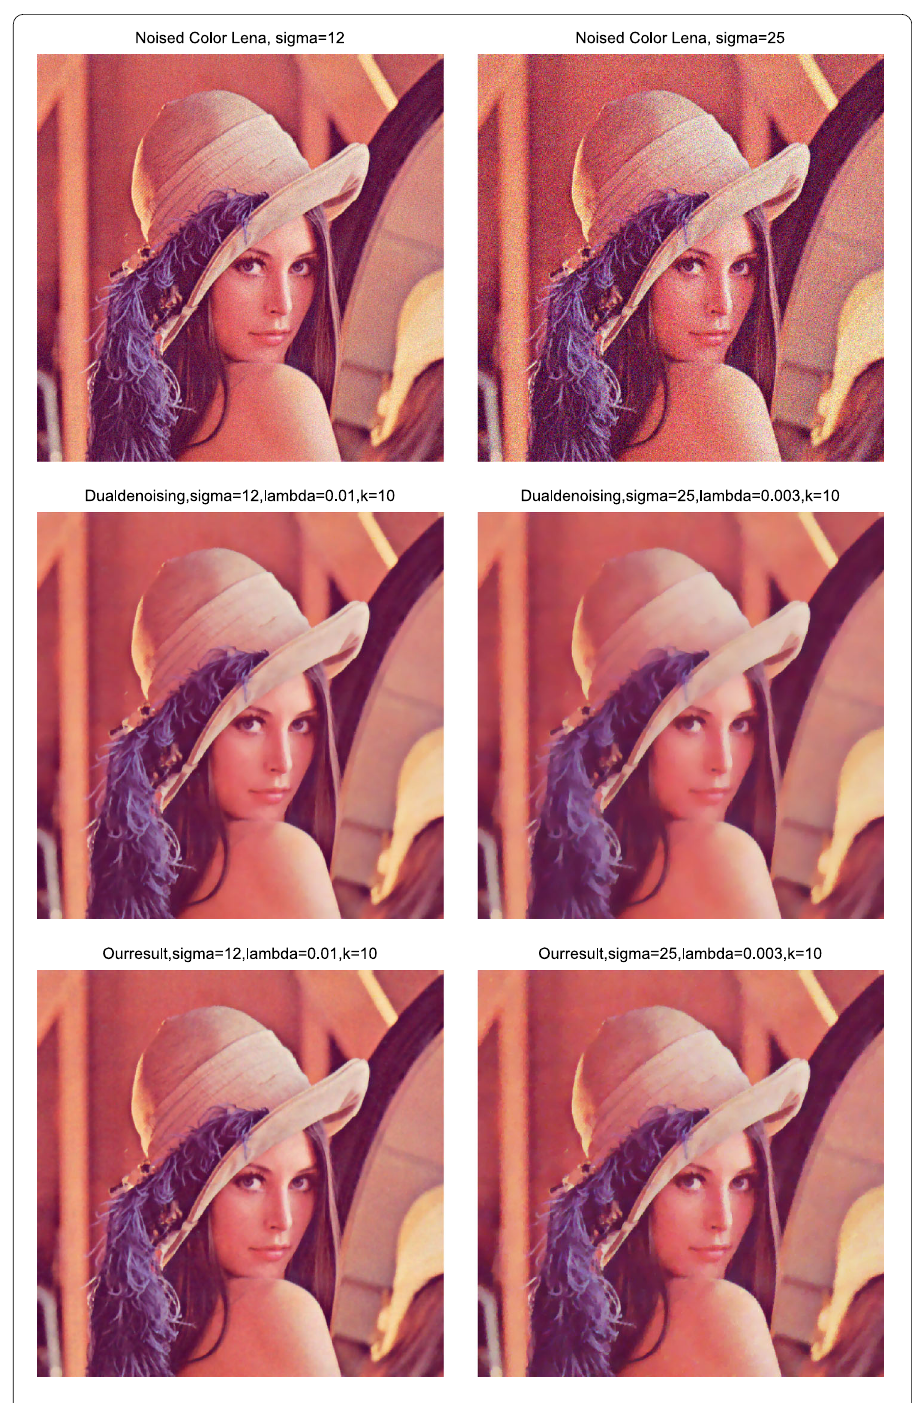
Figure 6 3-D Denoising results.